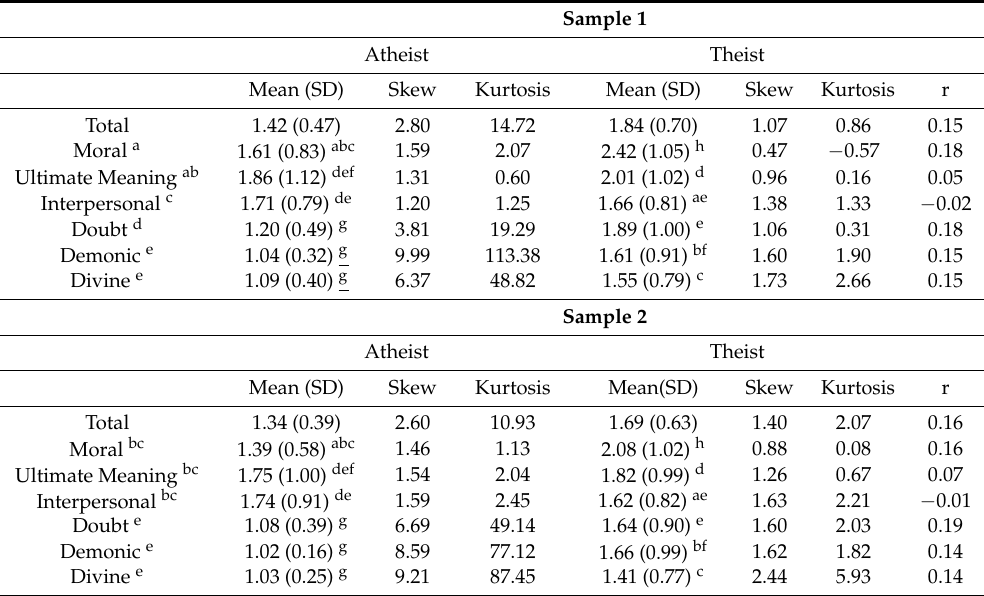
Table 2. RSS Scale Descriptive